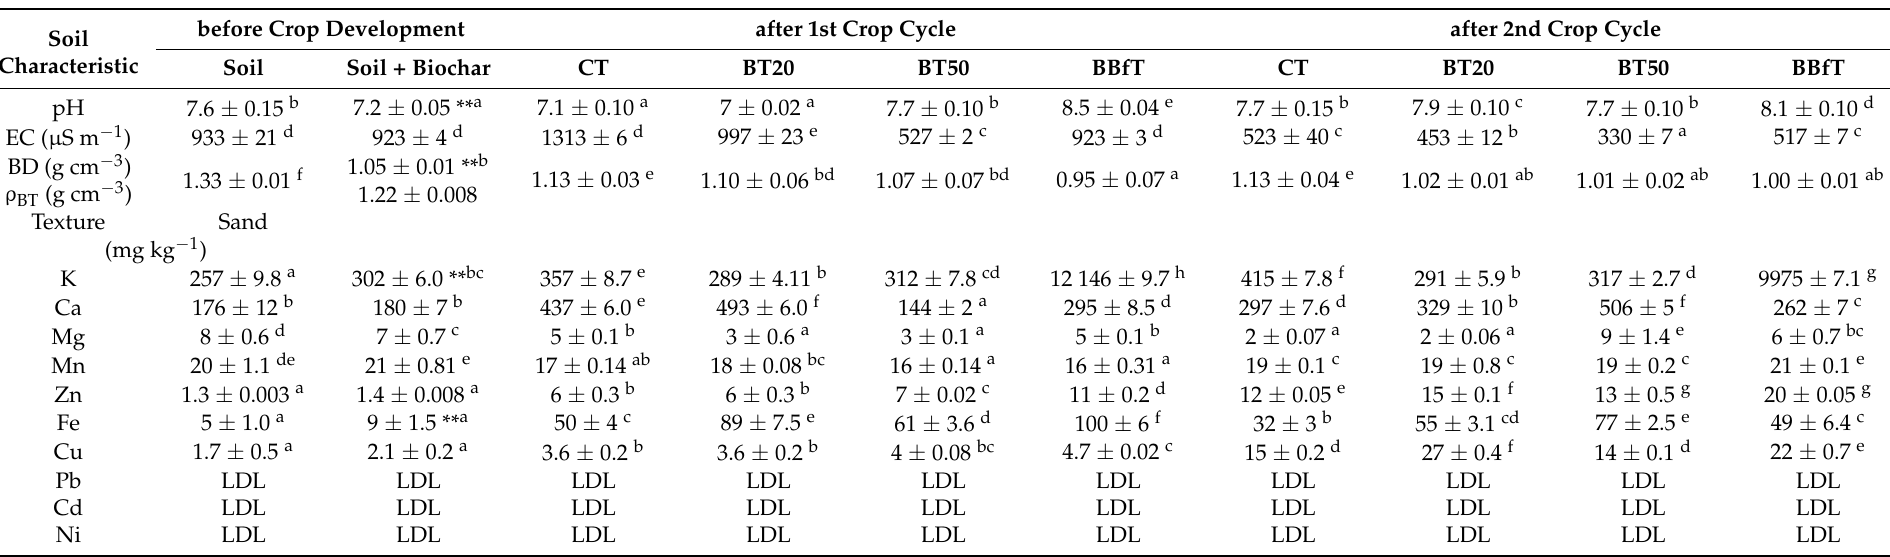
Table 3. Changes in soil by the application of biochar and the